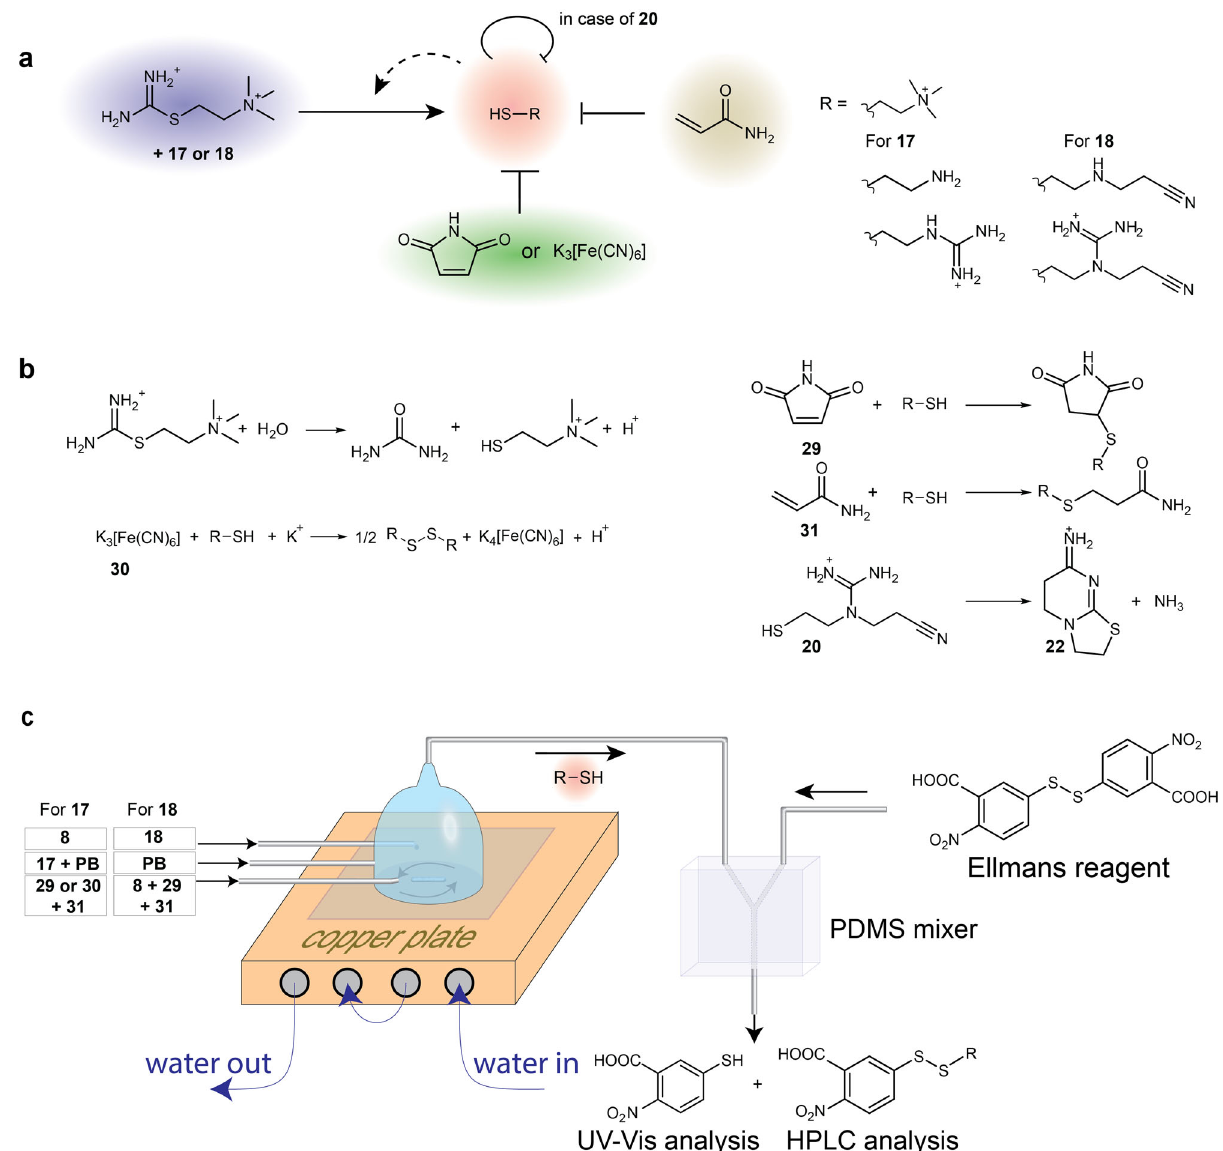
Fig. 5 Thiouronium salt-based oscillators. a A schematic layout of the oscillators based on the autocatalytic production of thiols from thiouronium salts and the suppression of this autocatalysis by maleimide or K 3 [Fe(CN) 6 ] and acrylamide (negative feedbacks). In case of the oscillator with disul fi de 18 , the autocatalysis is additionally suppressed by intramolecular cyclization 20 . b The schemes of the hydrolysis of 8 and, reactions of thiols with maleimide, K 3 [Fe(CN) 6 ], and acrylamide, and cyclization of 20 . c A schematic representation of the CSTR experimental set-up and downstream derivatization with Ellman ’ s reagent. The UV – -vis spectrometer detects the absorption of 4-nitro-3-carboxythiophenolate at 412 nm. The HPLC separates and quanti fi es the mixed disul fi des of 4-nitro-3-carboxythiophenole with 1 , 11 , and thiocholine. For analysis of oscillations in the concentration of 22 , the drops were directly collected from the outlet of the CSTR and analyzed by